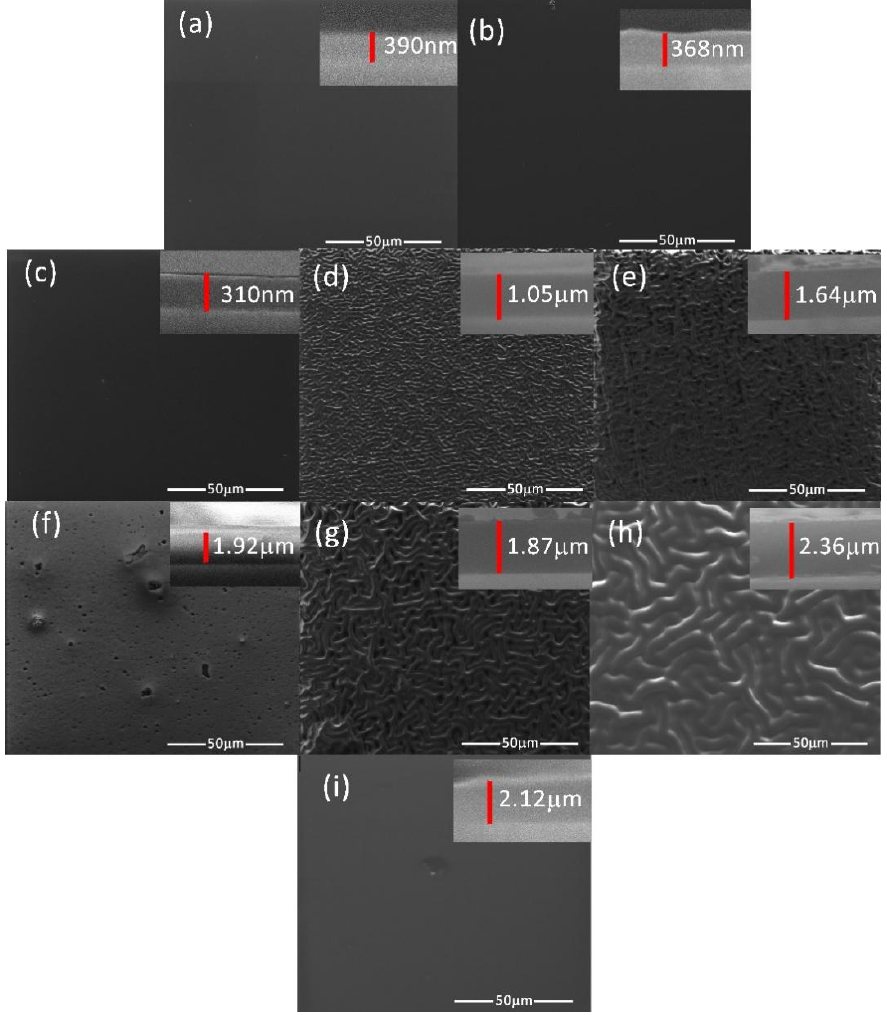
Figure 4. SEM images of: ( a ) PANI 1; ( b ) PANI 2; ( c ) PANI 3; ( d ) PANI 4; ( e ) PANI 5; ( f ) PANI 6; ( g ) PANI 7; ( h ) PANI 8; ( i ) POA layers.